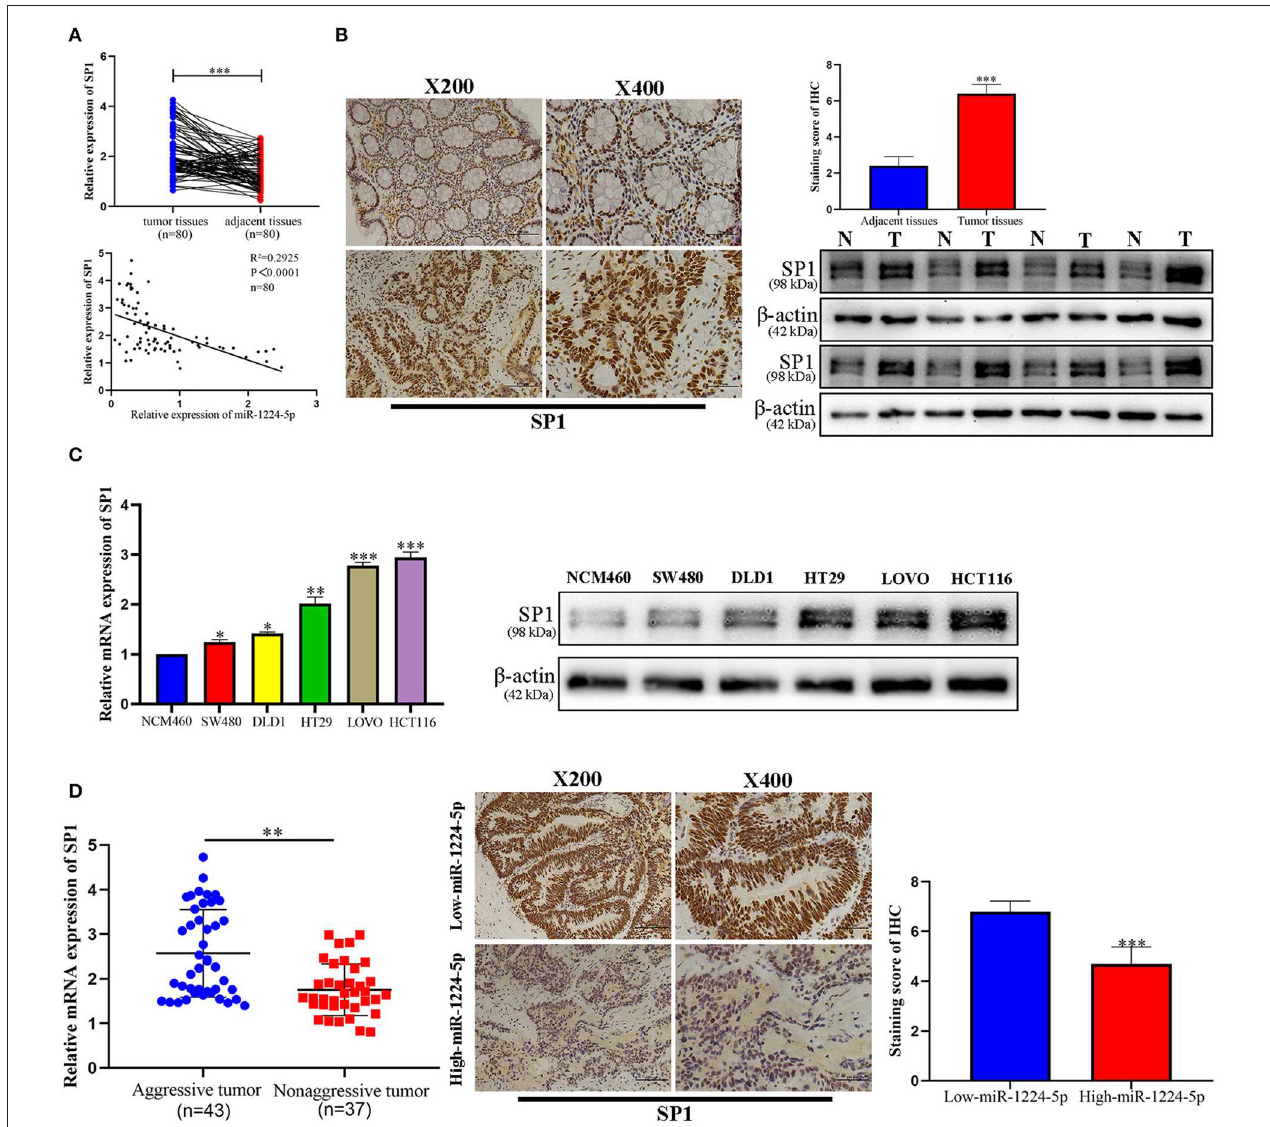
FIGURE 5 | Expression pattern of SP1 in CRC. (A) Expression of SP1 was upregulated in 80 paired CRC tissues compared with adjacent normal tissues and Pearson’s correlation analysis showed the negative correlation of SP1 with miR-1224-5p. (B) Immunohistochemistry showed the expression level of SP1 in CRC tissues and paired adjacent normal tissues, western blot showed the expression level of SP1 protein in 8 paired CRC tissues and adjacent normal tissues. (C) Expression of SP1 mRNA and protein in CRC cell lines and normal epithelial colon cell NCM460 were detected by qRT-PCR and western blot. (D) The mRNA expression of SP1 in aggressive tumors was significantly higher than that in non-aggressive tumors, as determined by qRT-PCR. Representative immunohistochemical staining showed a weak staining of SP1 in miR-1224-5p high-expressing CRC tissue and strong staining of SP1 in the miR-1224-5p low-expressing tumor. Data represent the mean ± SD from three independent experiments. Student’s t -test was used to determine statistical significance: * p < 0.05, ** p < 0.01, and *** p < 0.001.